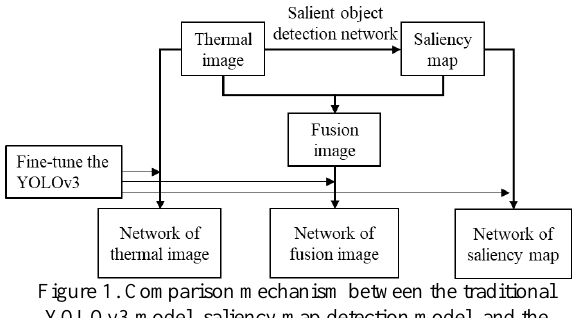
Figure 1. Comparison mechanism between the traditional YOLOv3 model, saliency map detection model, and the proposed